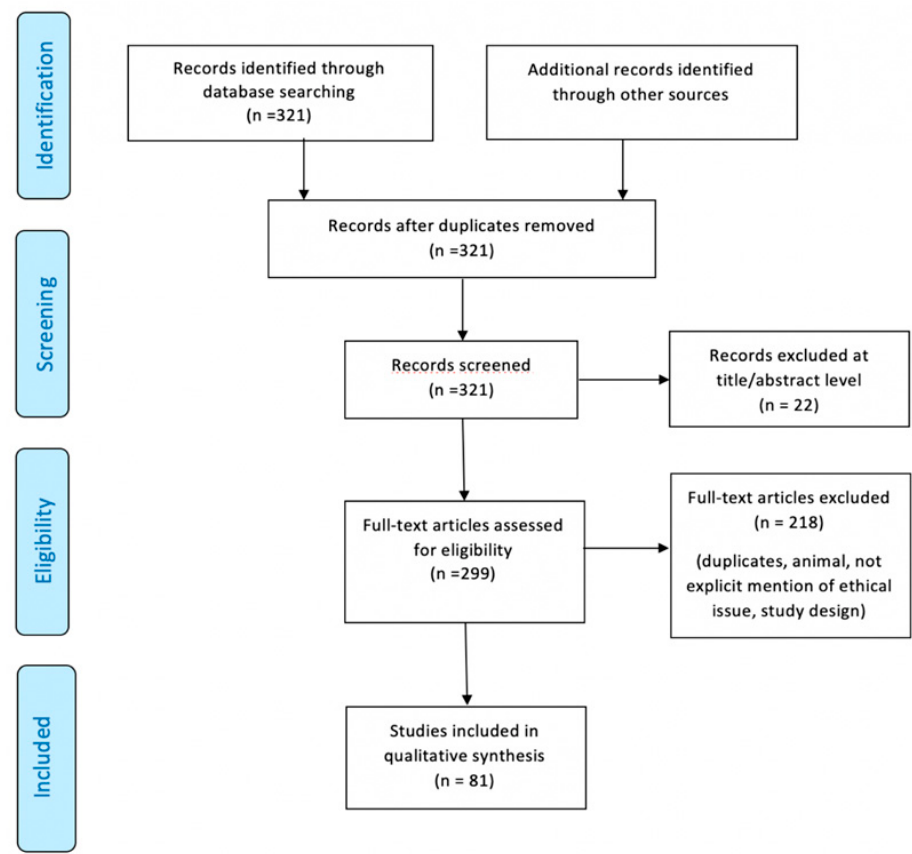
Figure 1. Preferred Reporting Items for Systematic Review (PRISMA) flow chart—search strategy.